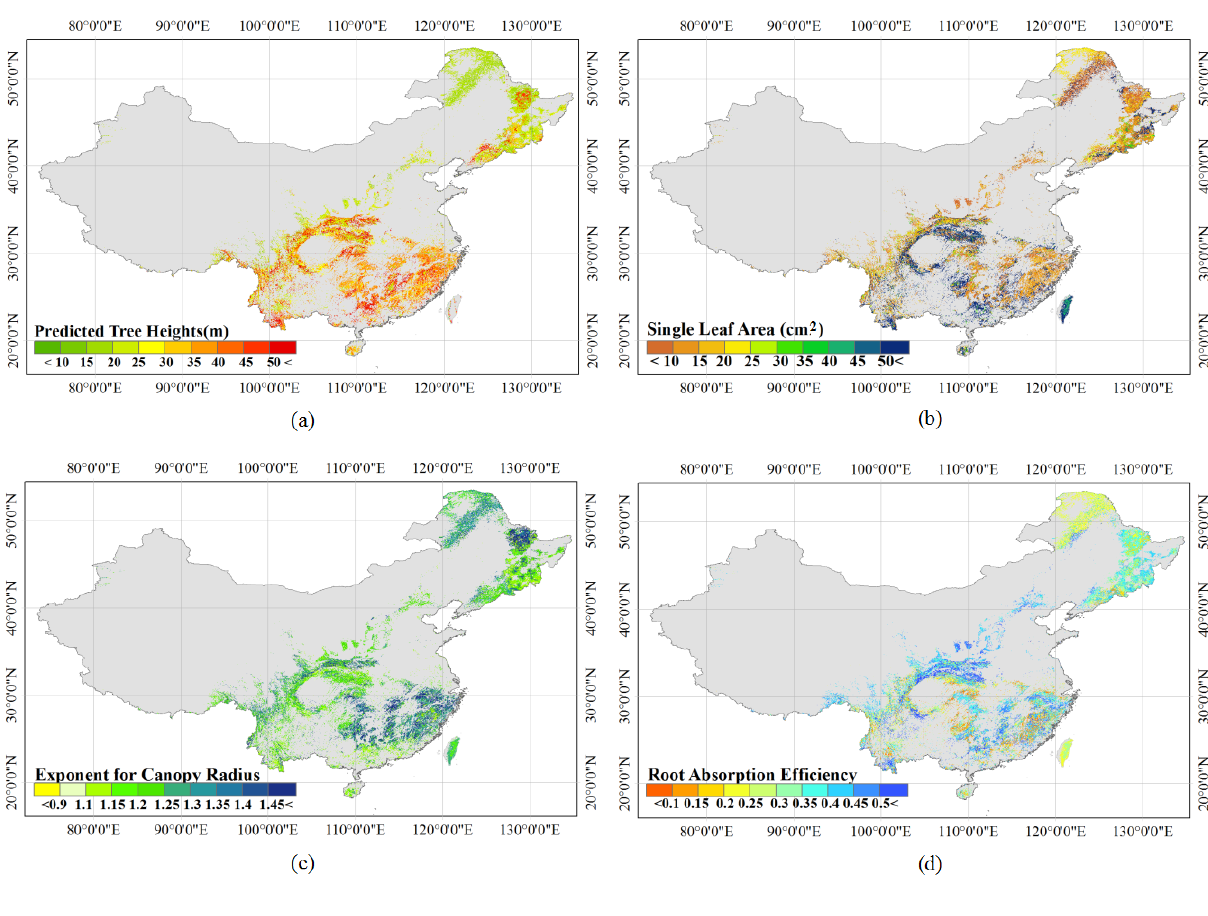
Figure 4. ( a ) Spatial distribution of tree heights predicted by the optimized ASRL model over the CONNA (1 km resolution). Spatial patterns of the optimized ( b ) single leaf area; ( c ) exponent for canopy radius; and ( d ) root absorption